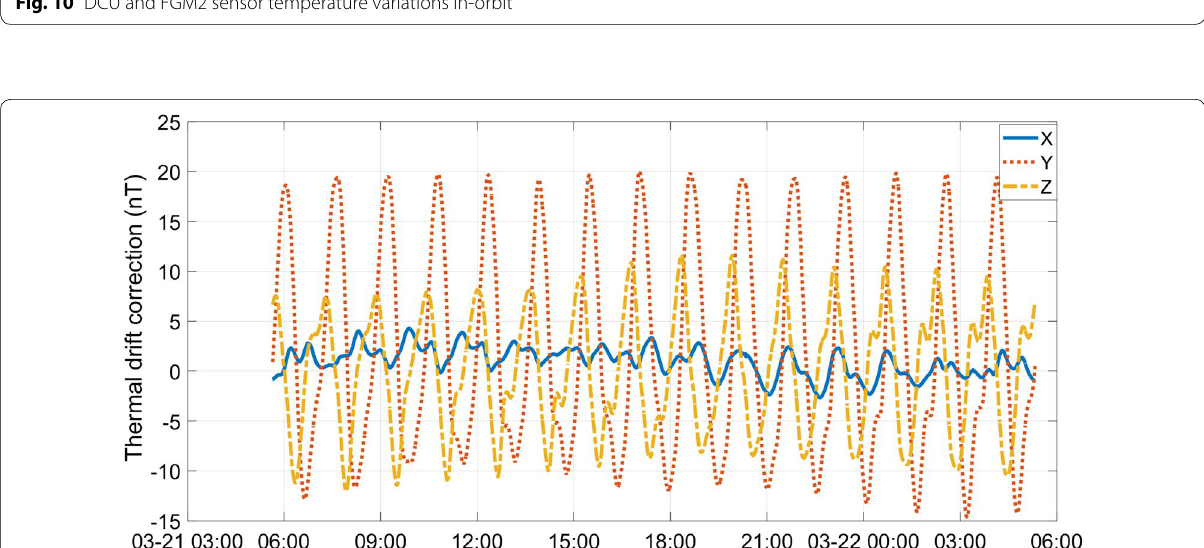
Fig. 11 FGM non-linear errors which can be corrected through thermal drift